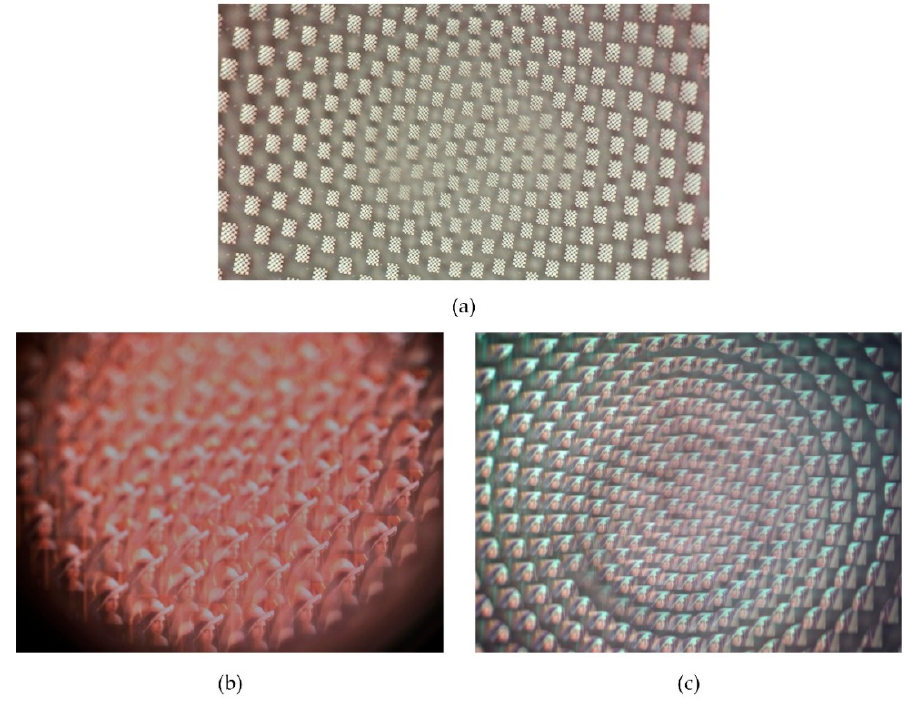
Figure 9. Images captured by the compound eyes: ( a ) calibration plate captured by the multi-focal compound eyes; ( b ) image of Lenna in contrast to the single focal compound eyes; ( c ) image of Lenna captured by the multifocal compound eyes.